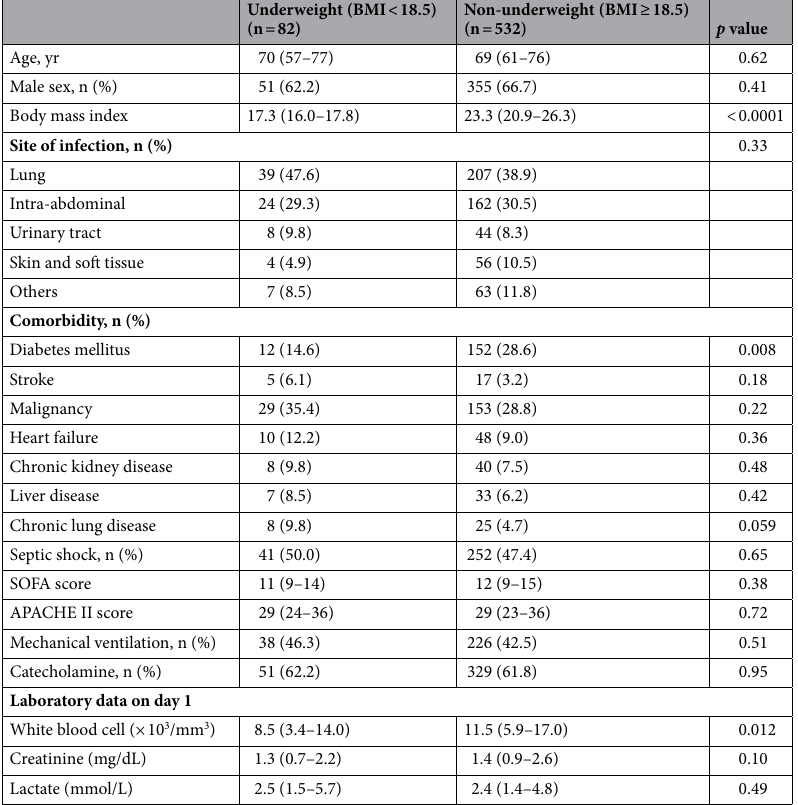
Table 1. Baseline characteristics in the derivation cohort. Data are presented as median (quartile). BMI body mass index, SOFA sequential organ failure assessment, APACHE acute physiology and chronic health